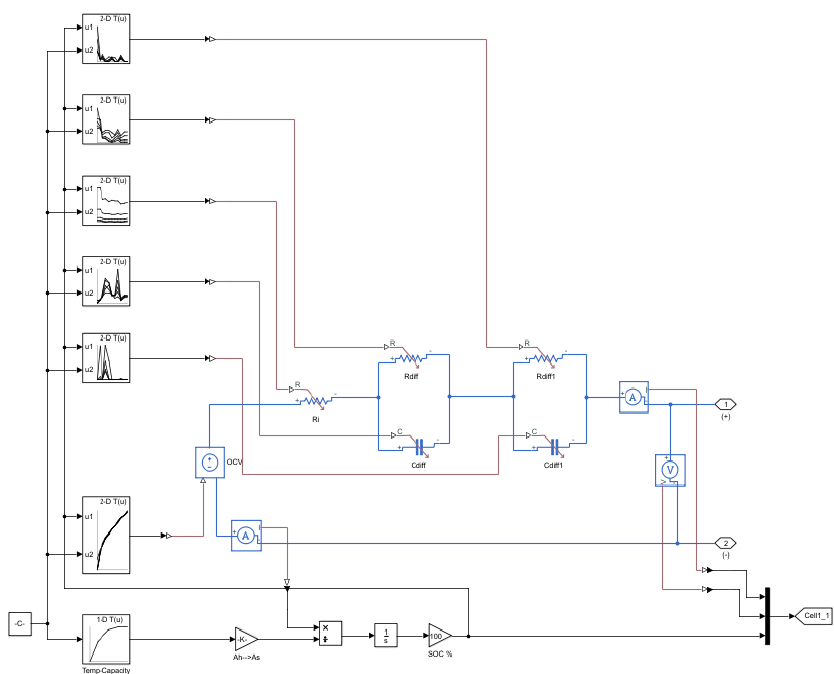
Figure 7. Second-order RC ECM modeling (MATLAB/Simulink/Simscape SW).